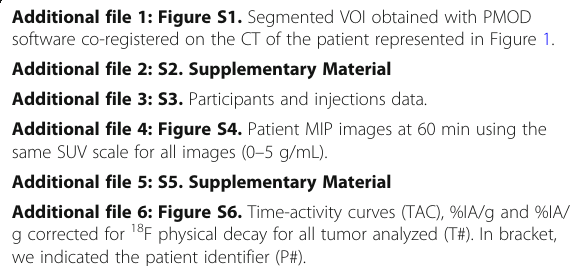
Additional file 2: S2. Supplementary Material Additional file 3: S3. Participants and injections